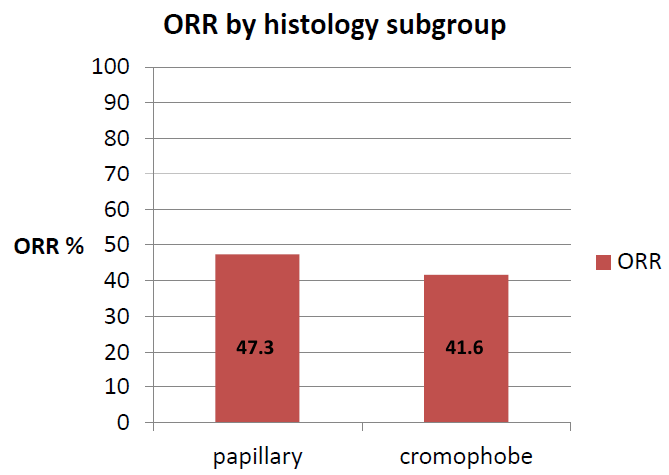
Figure 2. ORR according to histology subgroup.